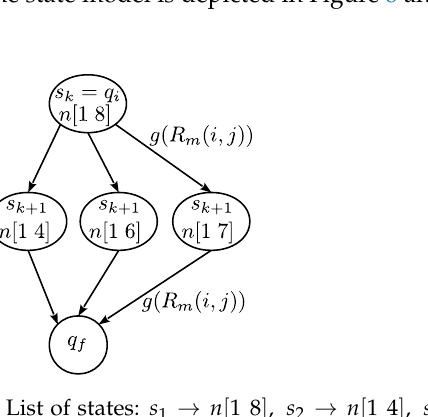
Figure 8. State model M = 5 states. List of states: s 1 → n [ 1 8 ] , s 2 → n [ 1 4 ] , s 3 → n [ 1 6 ] , s 4 → n [ 1 7 ] , s 5 → [ q f ] .